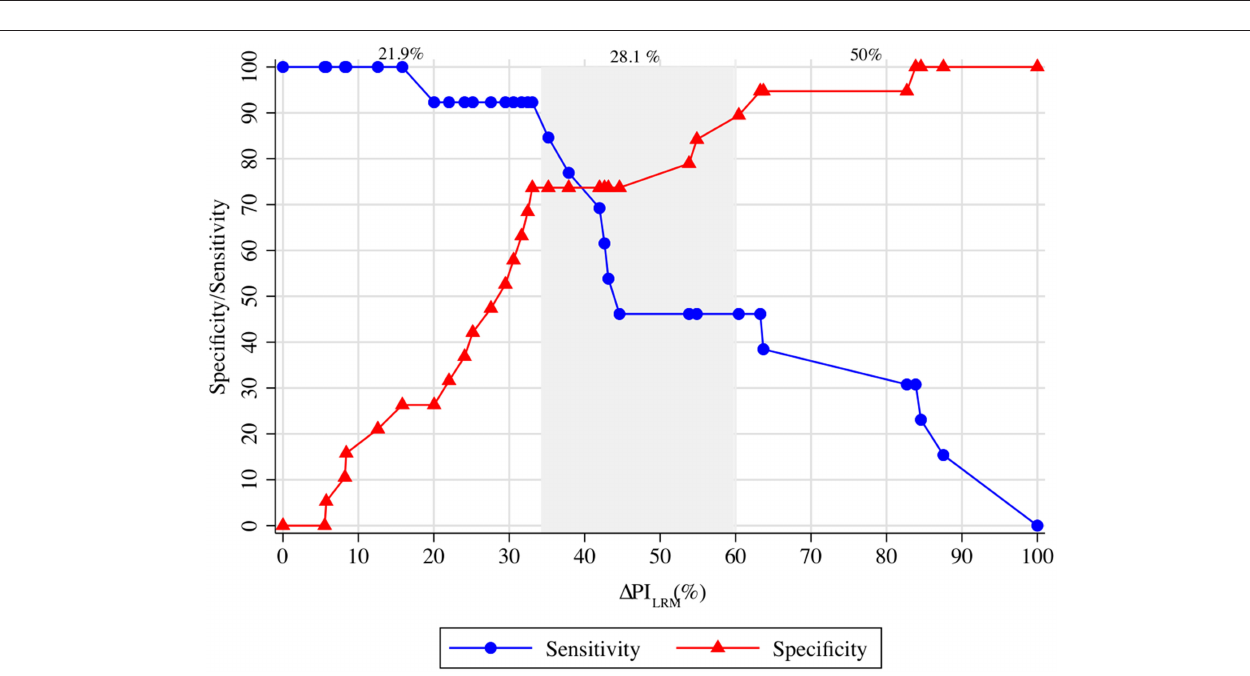
FIGURE 3 | The correlation between 1 SV LRM and 1 PI LRM in fluid responders (square) and non-responders (triangle), r 2 = 0.16, p = 0.020. LRM, lung recruitment maneuver; SV, stroke volume; PI, perfusion index.